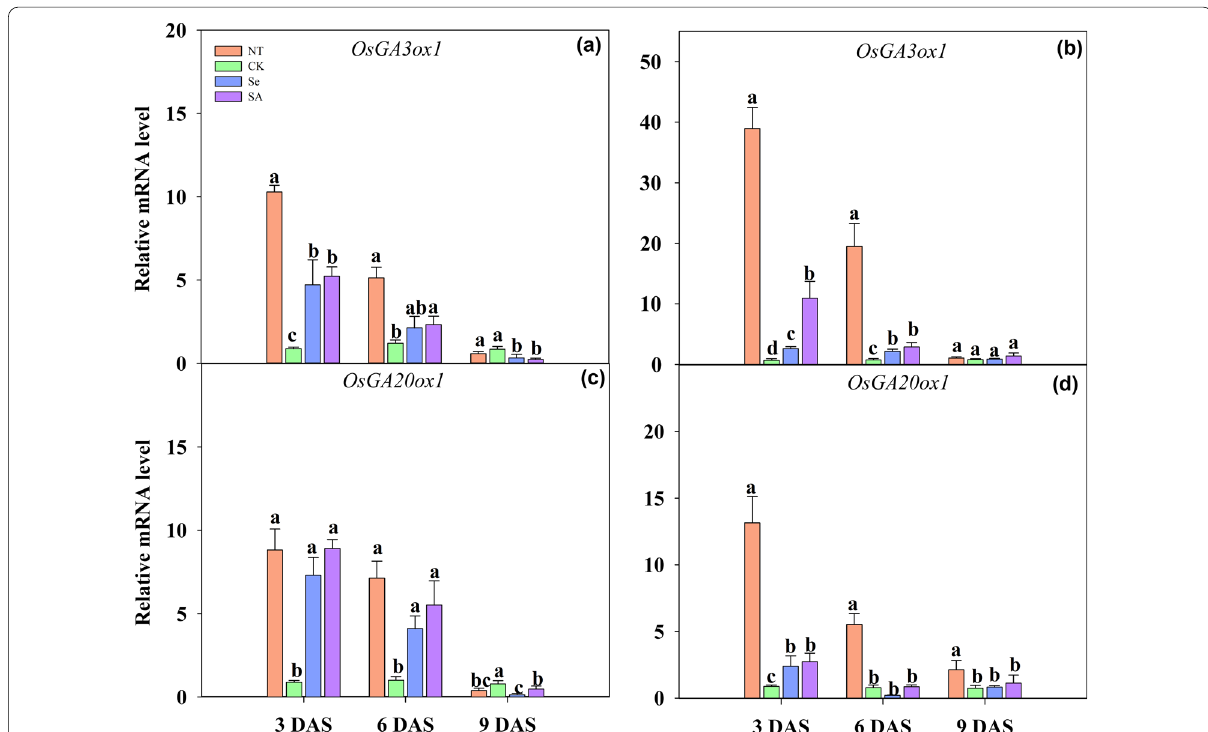
Fig. 6 Relative expression levels of GA biosynthesis genes of primed and non-primed rice seeds under control temperature and chilling stress. a, c EZ18; b, d LY287; a, b OsGA3ox1 ; c, d OsGA20ox1 . DAS, days after sowing; EZ18, ezao18; LY287, liangyou287; NT, no priming-normal temperature control; CK, no priming-chilling stress; Se, Selenium priming-chilling stress; SA, Salicylic priming-chilling stress. Error bars indicate standard error (n 3). Different lowercase letters denote statistical differences at the 5% level according to LSD test among four treatments within the same DAS = of the same variety